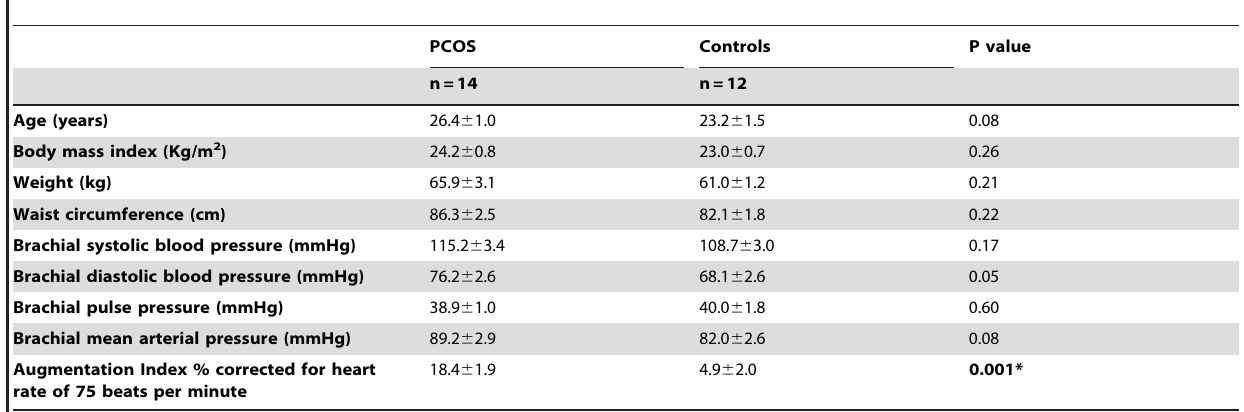
Table 1. Selected clinical, biochemical and brachial blood pressure measurements in non-obese subjects with PCOS and age and body mass index matched healthy